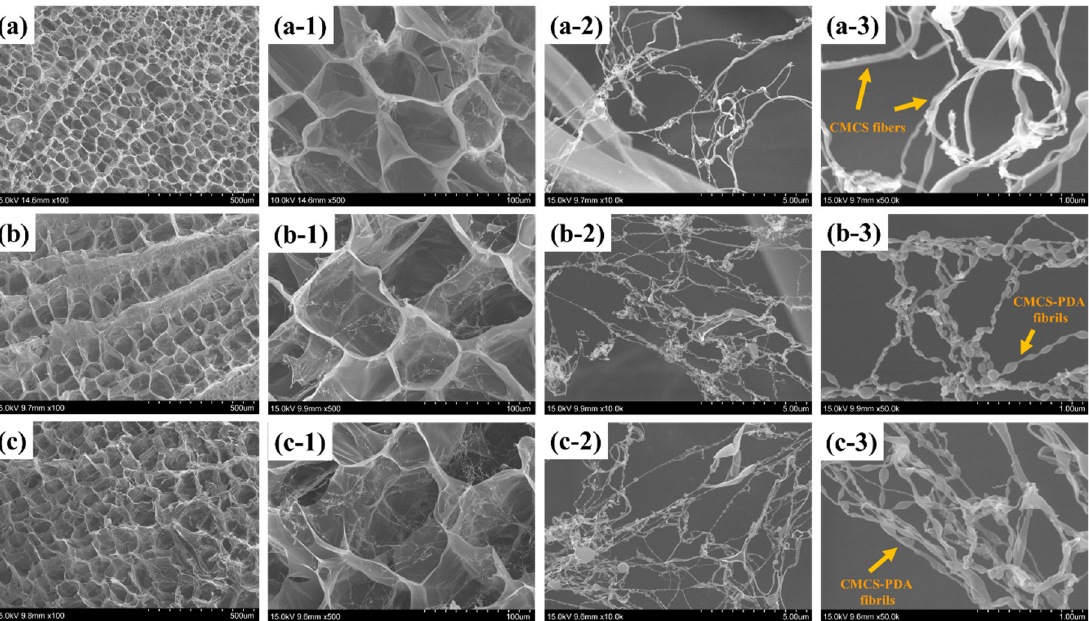
Figure 5. SEM images of hydrogels ( a ) FCMCS (low resolution) and ( a-1 – a-3 ) (high resolution), ( b ) 0.2DA-FCMCS (low resolution) and ( b-1 – b-3 ) (high resolution), and ( c ) 0.4DA-FCMCS (low resolution) and ( c-1 – c-3 ) (high resolution).